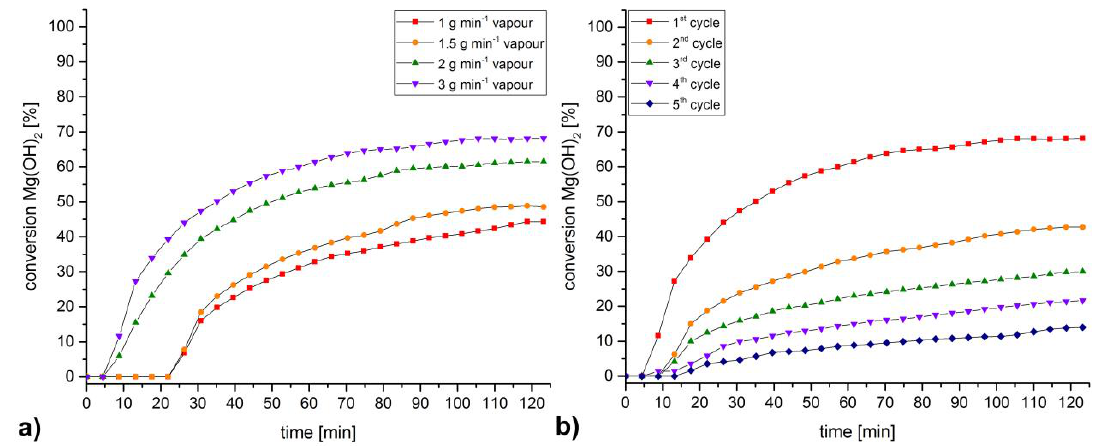
Figure 2. ( a ) Rehydration of Mg(OH) 2 -originating MgO with various water vapour flow rates; ( b ) Cycle stability of Mg(OH) 2 -originating MgO.